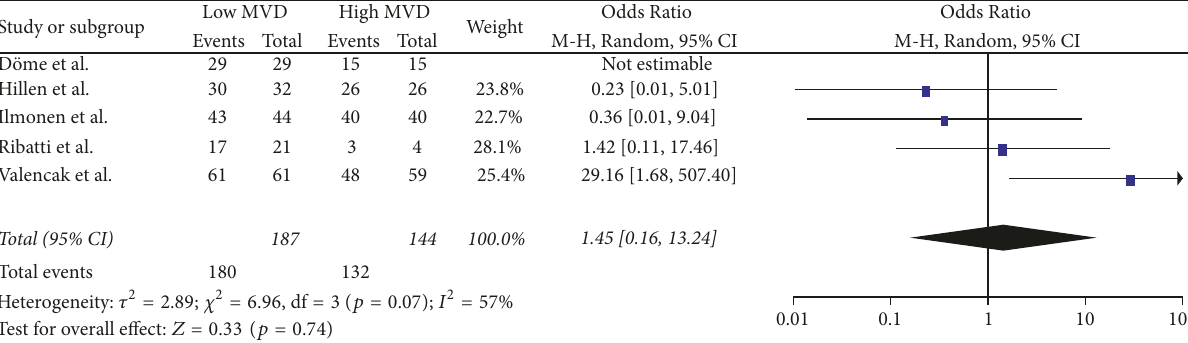
Figure 4: 12 months’ overall survival.